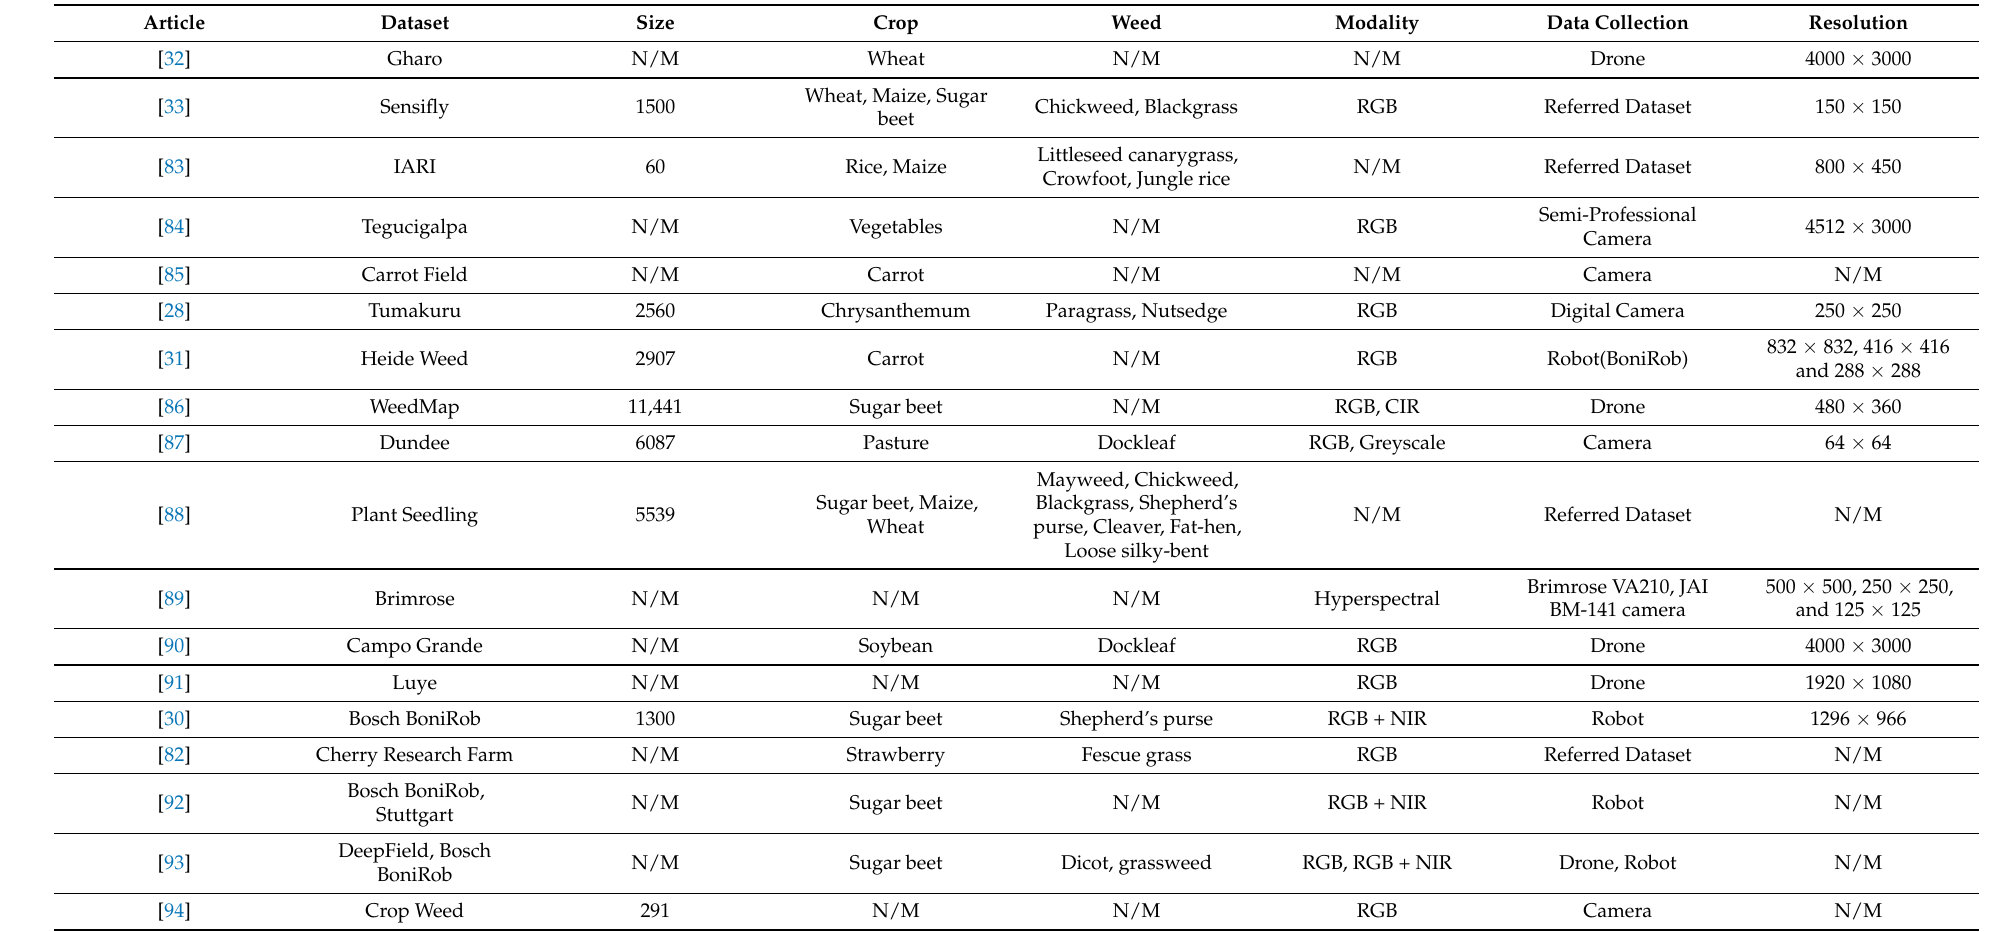
Table 2. Information regarding weed datasets used in application